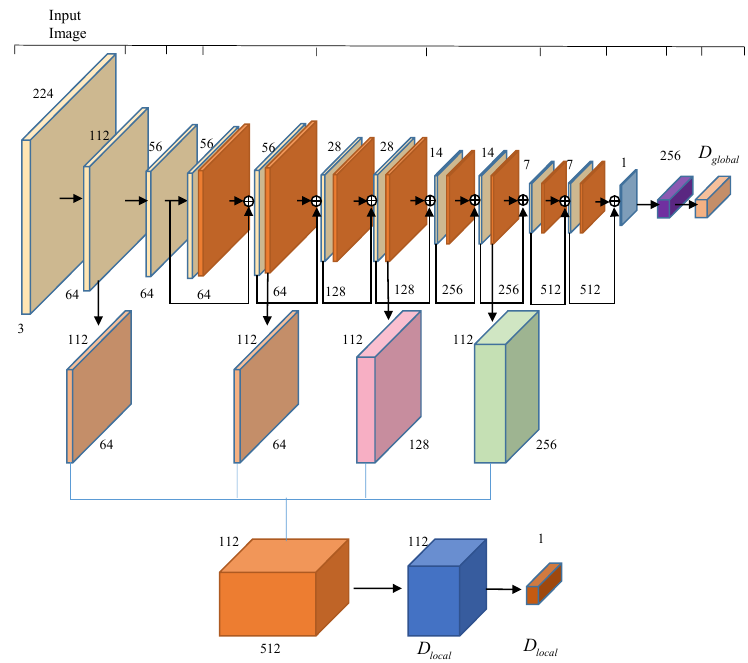
Figure 3. Encoder network architecture.